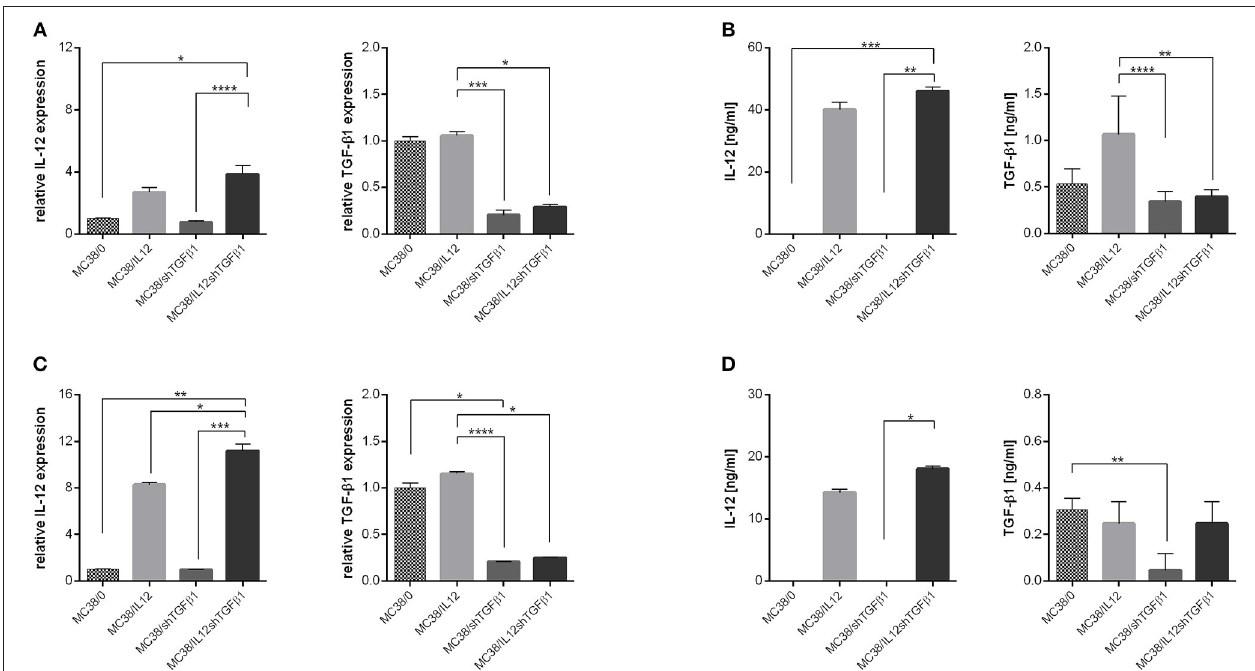
FIGURE 1 | Effectiveness of IL-12 overexpression and TGF- β 1 silencing in genetically modified MC38 cell lines. (A,C) Relative expression of IL-12 and TGF- β 1 measured by real-time PCR in MC38 cells cultured in normoxic (A) or hypoxic (C) conditions. (B,D) Concentration of IL-12 and TGF- β 1 in supernatants from MC38 cells cultured in normoxic (B) or hypoxic (D) conditions. The results are given as the mean ± SD calculated for at least two repeats in two independent experiments. The differences between the groups were estimated using the nonparametric Kruskal-Wallis test followed by Dunn’s multiple comparison test (* p < 0.05, ** p < 0.01, *** p < 0.001, **** p <